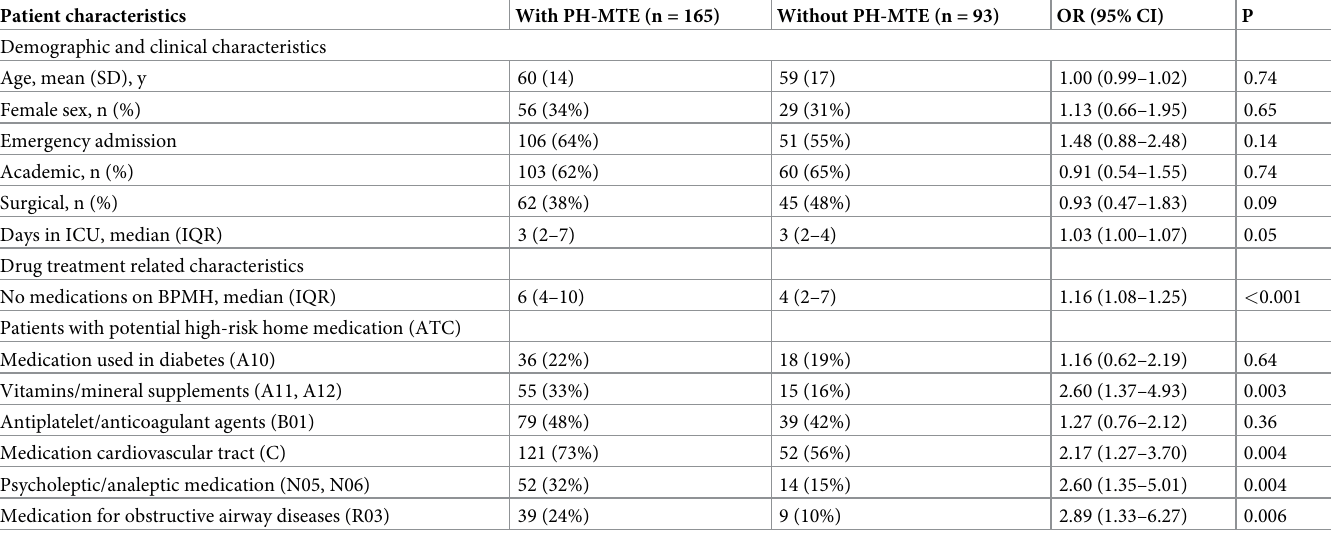
Table 1. Demographic, clinical and drug treatment related characteristics of the patient population, potential